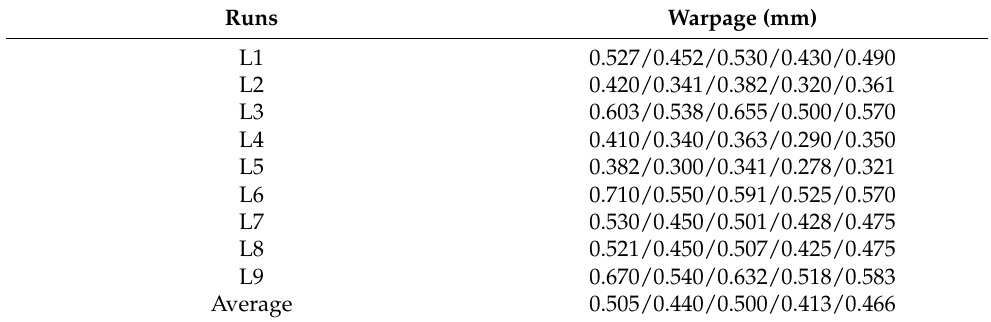
Table 5. Warpage of the micro-sized part in the experiment for PIM (POM/ABS/PP/PA/ABS + PC). Runs Warpage (mm)